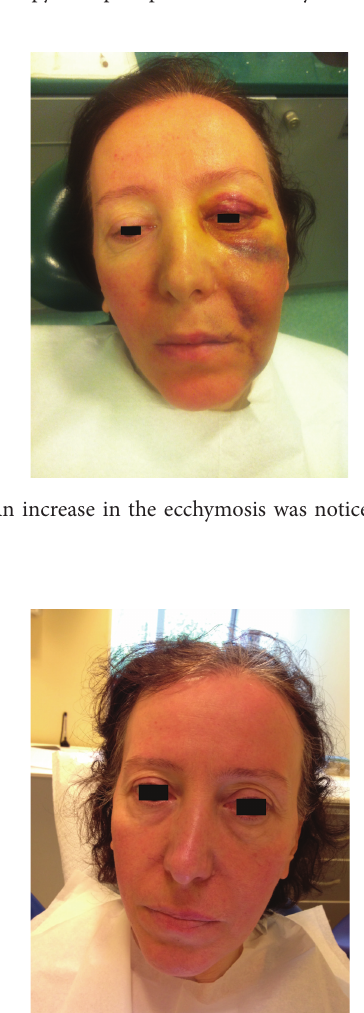
Figure 2: Panoramic radiography showed evidence of a previous root canal therapy with periapical radiolucency.